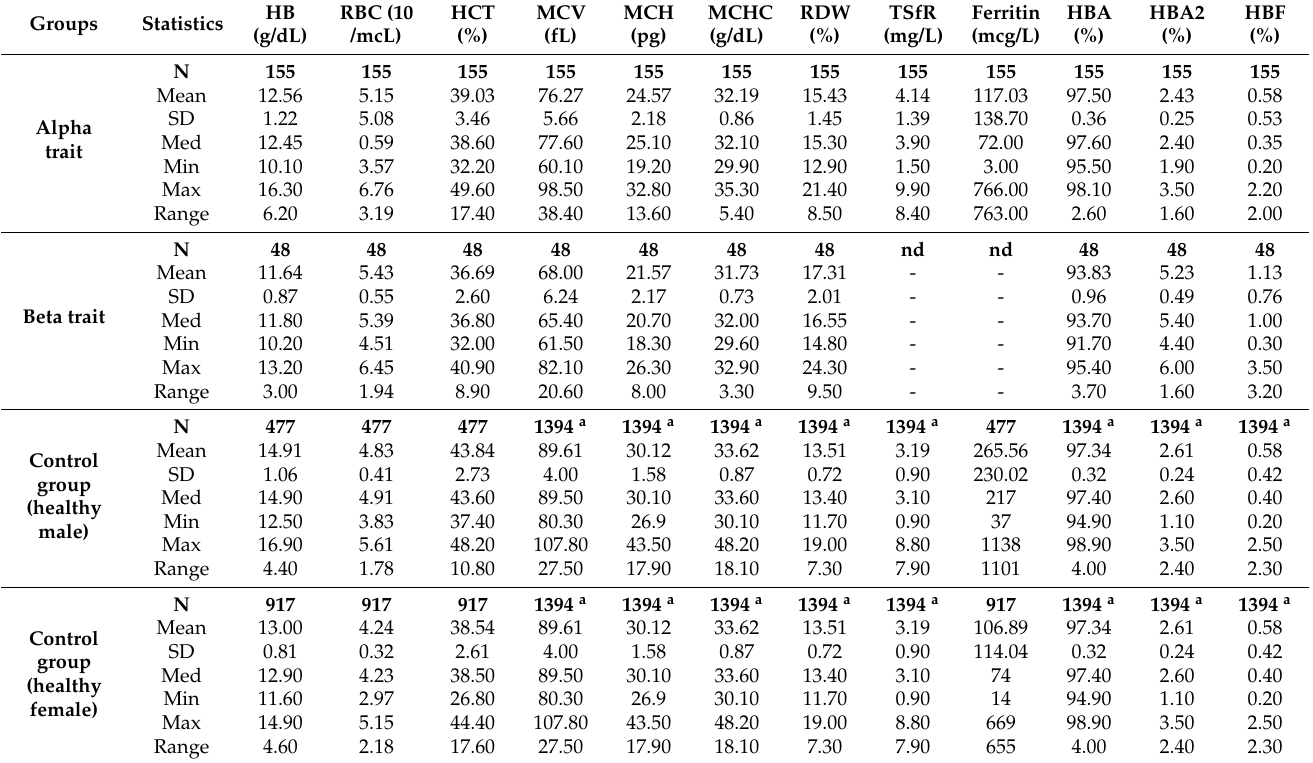
Table 1. Distribution of cases and statistics of RBC parameters, serum ferritin, haemoglobin analysis (HBA, HBA2, and HBF). Groups